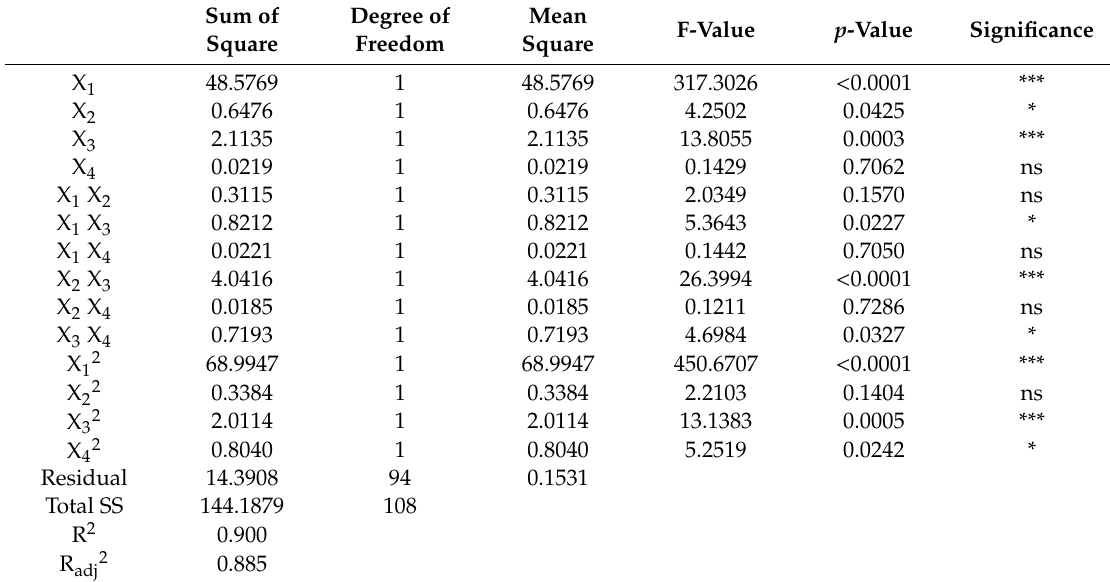
Table 2. ANOVA for the second-order polynomial equation for microwave-assisted extraction of total phenolic compounds